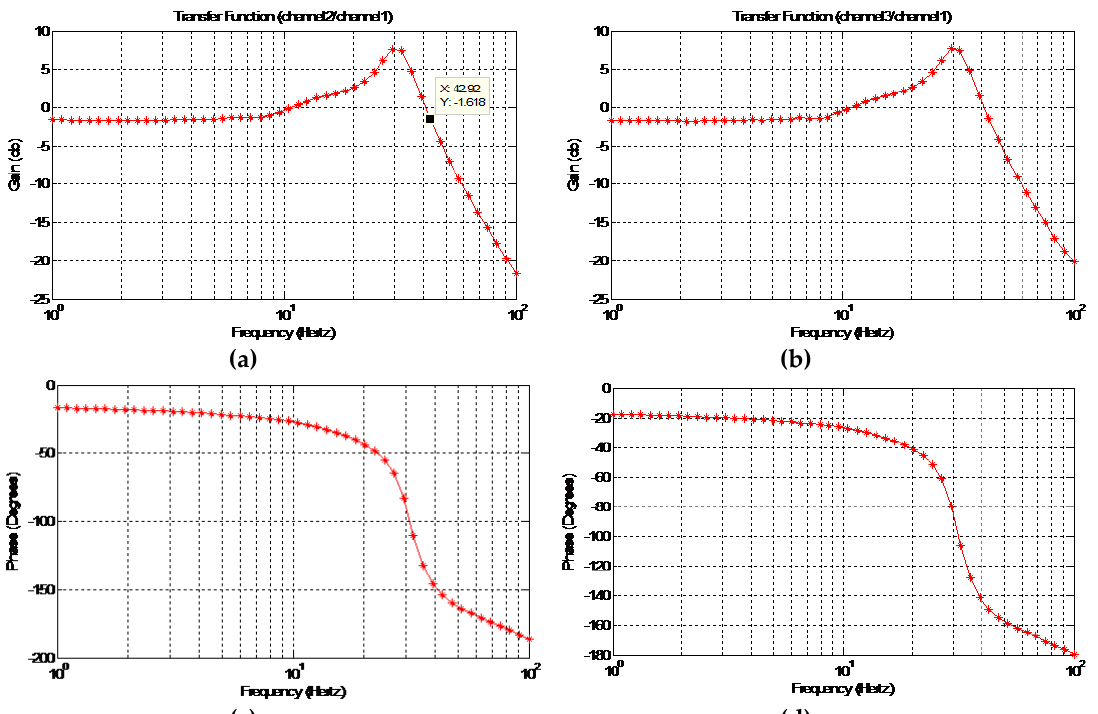
Figure 10. The Bode diagram of VCM closed loop sweep frequency. ( a ) Amplitude frequency curves, in which the output signal is the angle signal after Hall sensor calibration; ( b ) amplitude frequency curves, in which the output signal is the incremental encoder angle signal; ( c ) phase frequency curves, in which the output signal is the angle signal after Hall sensor calibration; ( d ) phase frequency curves, in which the output signal is the incremental encoder angle signal.